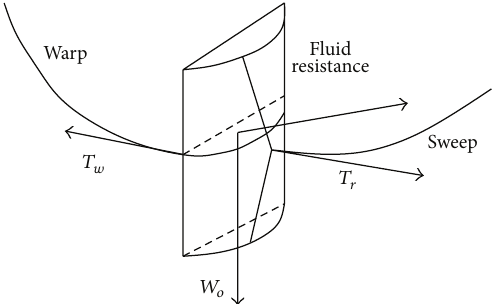
Figure 2: Diagrammatic sketch of otter